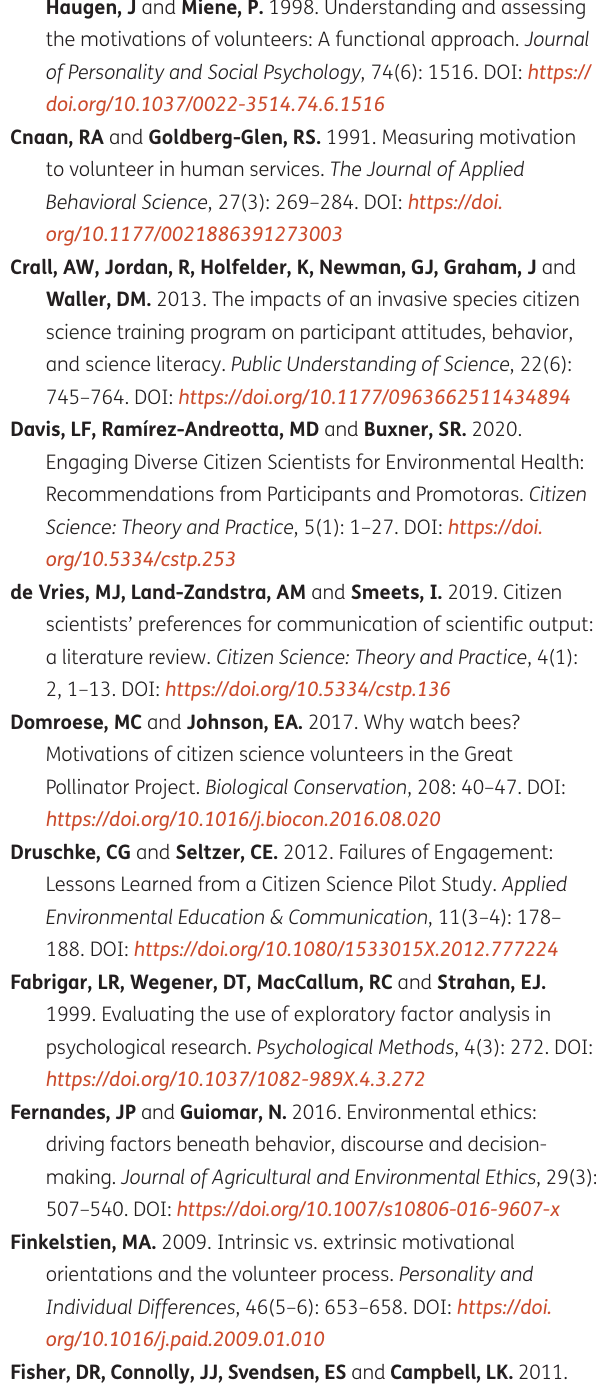
Table 4: Volunteers by type of main organization for which volunteer activities were performed and